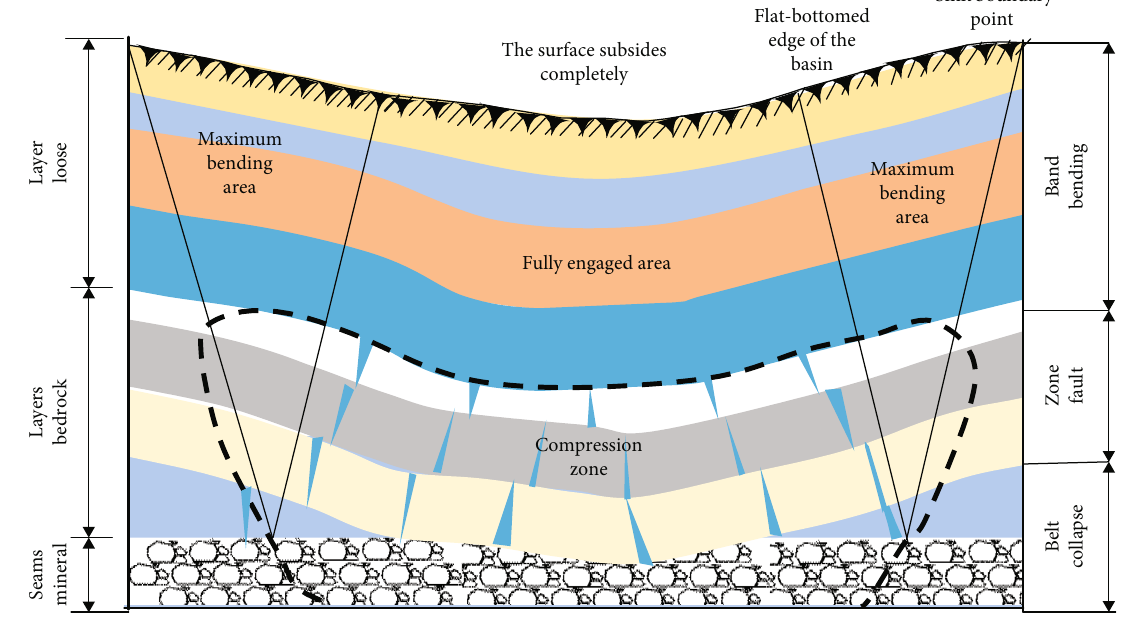
Figure 6: Mining in fl uence